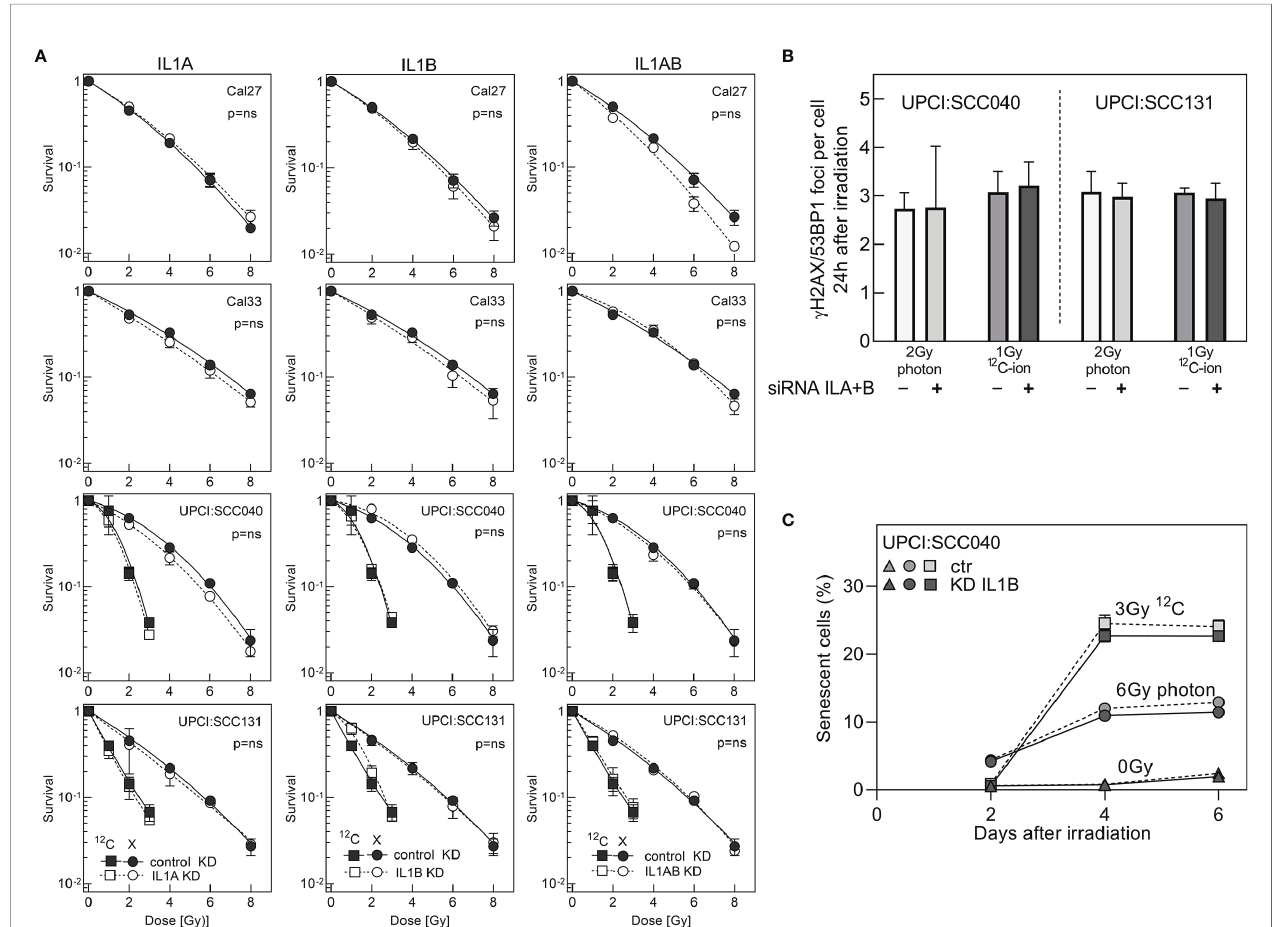
FIGURE 5 | Cell survival after siRNA knockdown of ILA or/and IL1B. (A) Colony formation assay was initiated 1 day after transfection. Knockdown and control cells were irradiated with 2 – 8 Gy photons or 1 – 3 Gy 12 C-ions. (B) Foci formation in response to 2-Gy photons or 1-Gy 12 C-ions was examined by g H2AX/53BP1 immuno fl uorescence 24 h after irradiation. (C) Flow cytometry-based analysis of senescence after siRNA knockdown of IL1B in the cell line UPCI:SCC040. IL1B knockdown and control samples were irradiated with 6 Gy photon or 3 Gy 12 C-ion, and senescence was determined from days 2 to 6 after irradiation. Experiments were performed in triplicates. MV+/- SEM are given. p values were calculated using t-test statistics. p = ns describes no signi fi cance was